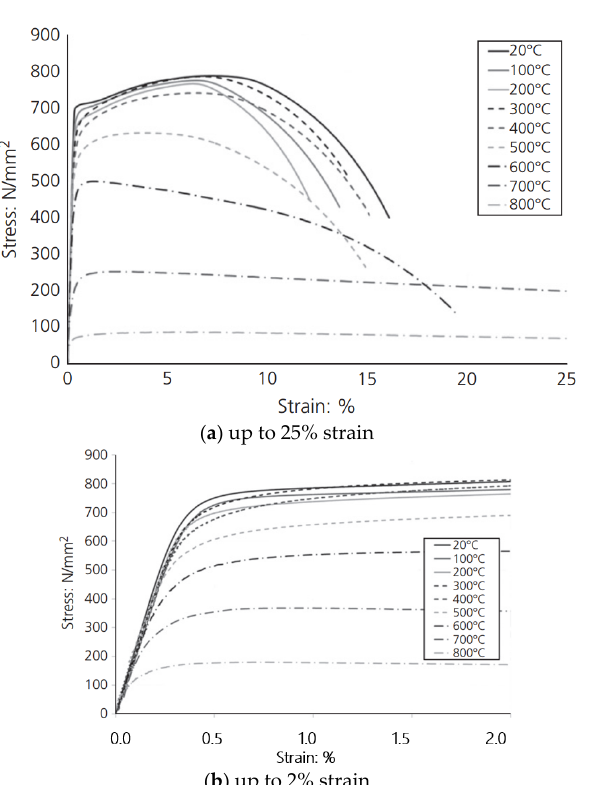
Figure 6. Engineering stress-strain curves for steel S690QL from 20 to 800 °C from Winful et al. [30]. Table 2. Material properties of CFS S690QL steel grade [30].